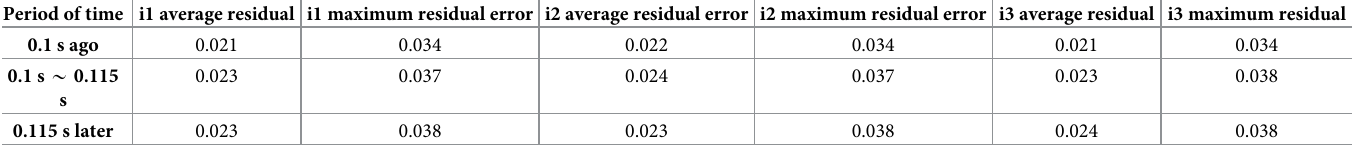
Table 8. Comparison of current residual values of each sensor under simulation of multiple faults occurring in